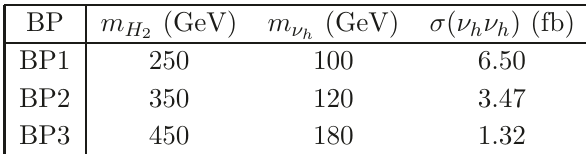
Table 1 . Benchmark points for the heavy neutrino pair production via the heavy scalar. The first and second columns give the heavy Higgs and the heavy neutrino masses, respectively. The third column displays the total cross